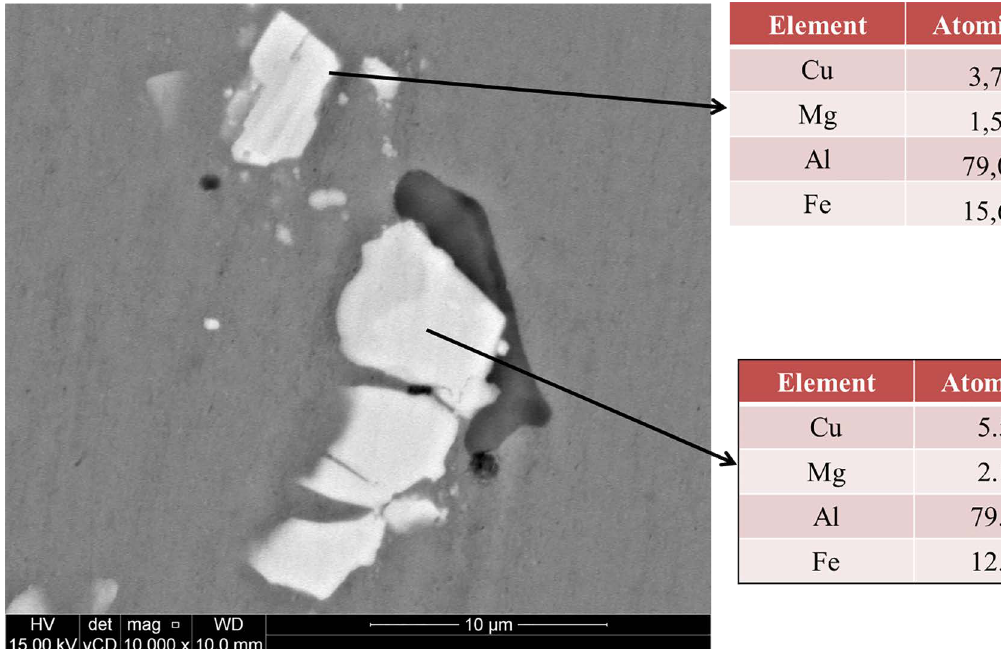
Figure 2. SEM image of observed particles.